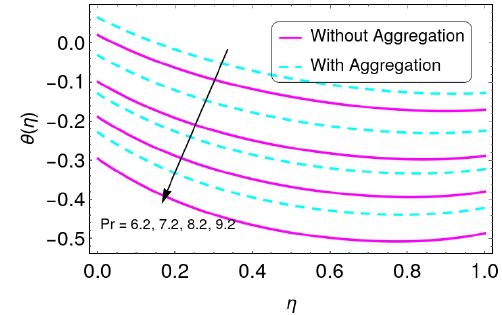
Figure 15. Characteristics of Pr for θ ( η ) .